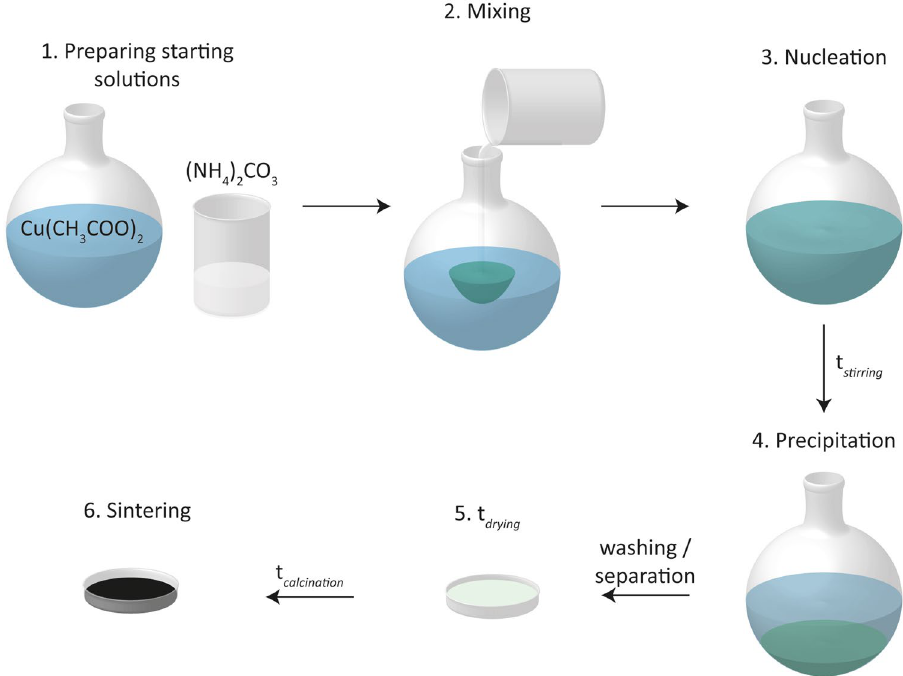
Figure 1. Schematic of the executed steps in the sol-gel synthesis and subsequent calcination